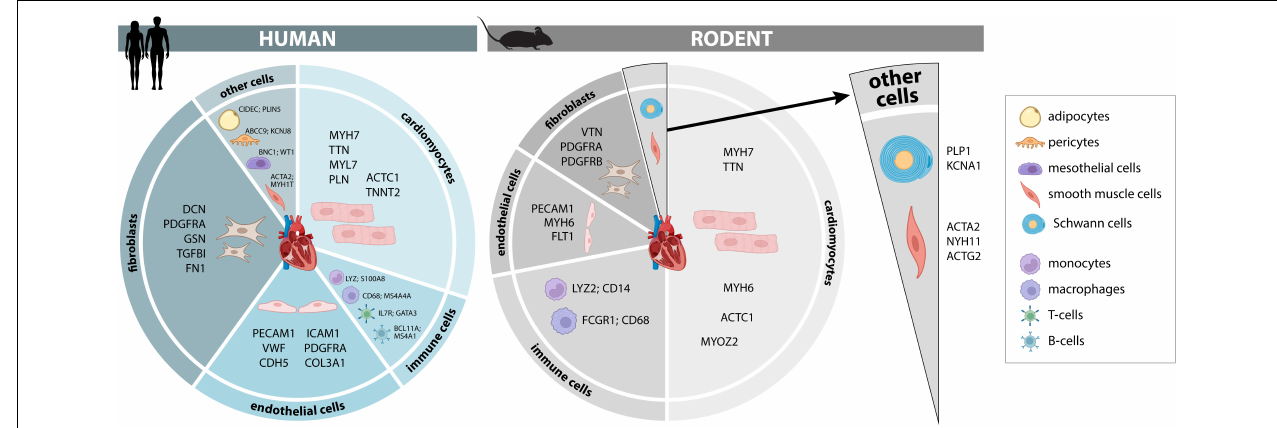
FIGURE 1 | Cellular composition and markers of the human and murine heart. Cellular composition and most consistently identified markers that may be used for identification and separation of major cellular lineages in adult human and murine hearts. A more comprehensive list of additional marker genes, including fetal human hearts, is provided in Supplementary Tables 1–3